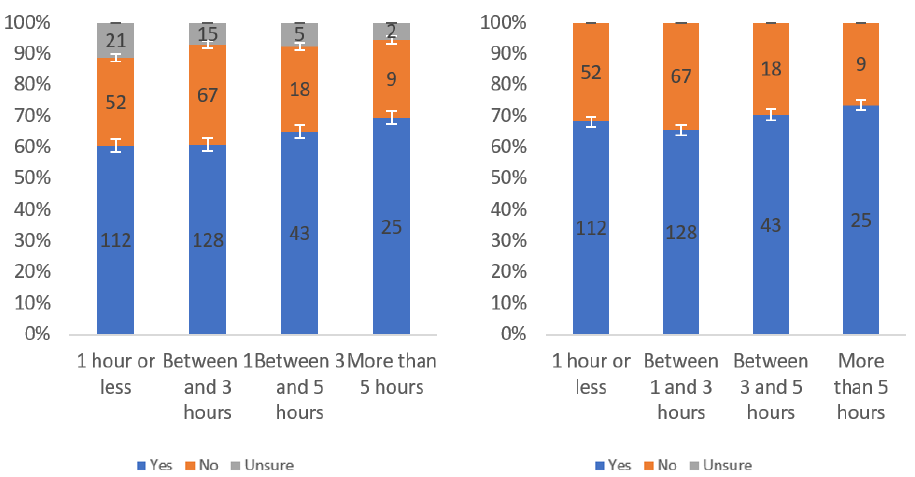
Figure 41. Responses regarding label helpfulness by internet usage level including ( left ) and excluding ( right ) unsure responses.